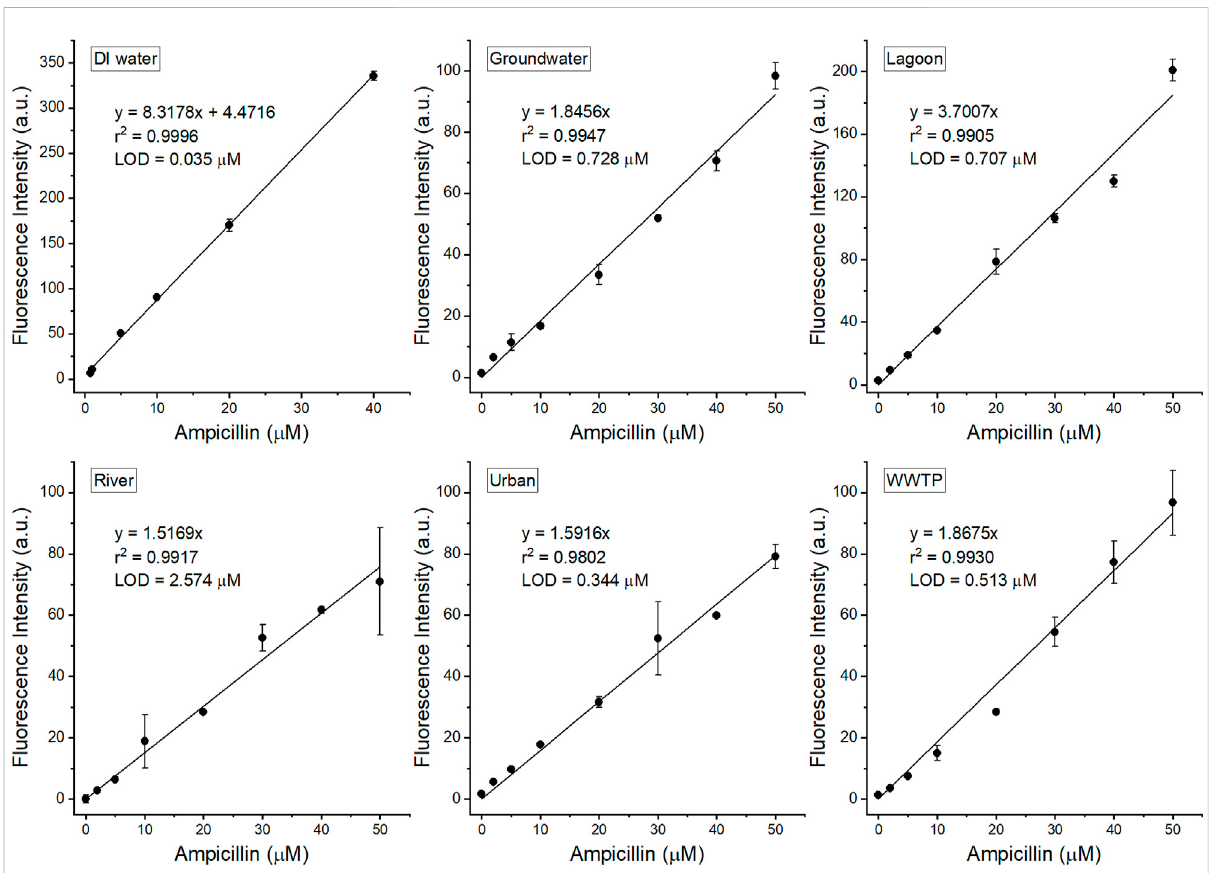
FIGURE 3 Calibration curves and LODfor thedetection ofampicillin based onthe fl uorescence intensity ofabyproductofthebiocatalyticdegradationof ampicillin by CPO in different environmental water